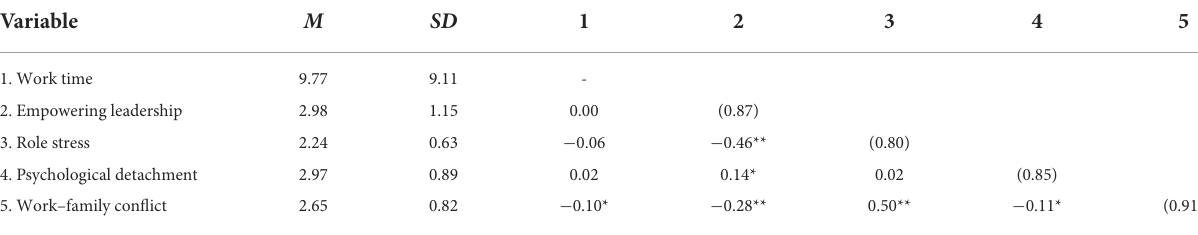
TABLE 2 Descriptive statistics and correlations between the major variables.